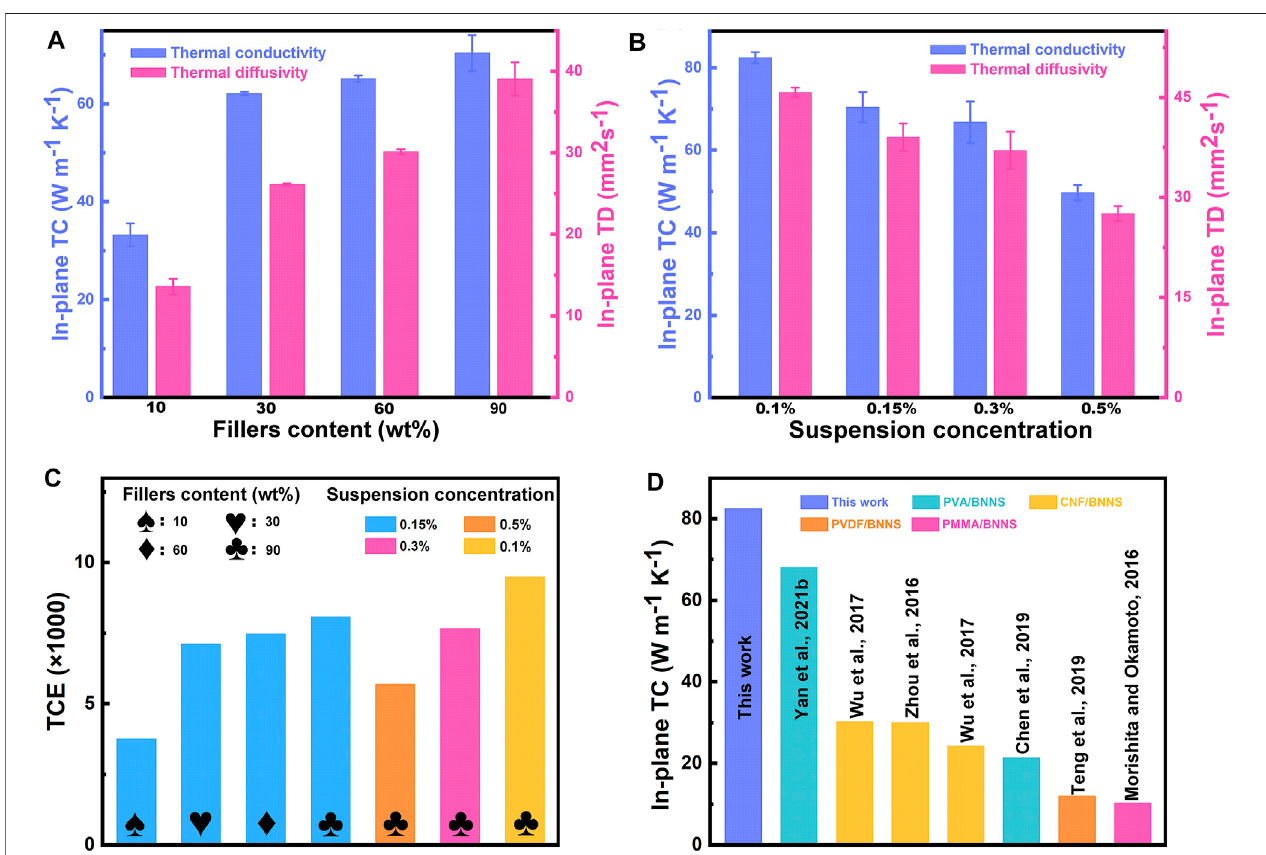
FIGURE5| Thermal properties ofCNF/BNNS composite fi lms: (A) Thermal conductivity(TC) and thermal diffusivity (TD) ofCNF/BNNS composite fi lmsat different BNNS fi llercontents at asuspension concentration of0.15 wt%, (B) Thermal conductivityand thermal diffusivityofCNF/BNNS composite fi lmswith90 wt%BNNS fi ller contentatdifferentsuspensionconcentrations, (C) Thermalconductivityenhancement(TCE) , and (D) ComparisonbetweenoursamplesandBNNS/polymercomposite fi lms reported in the literature.